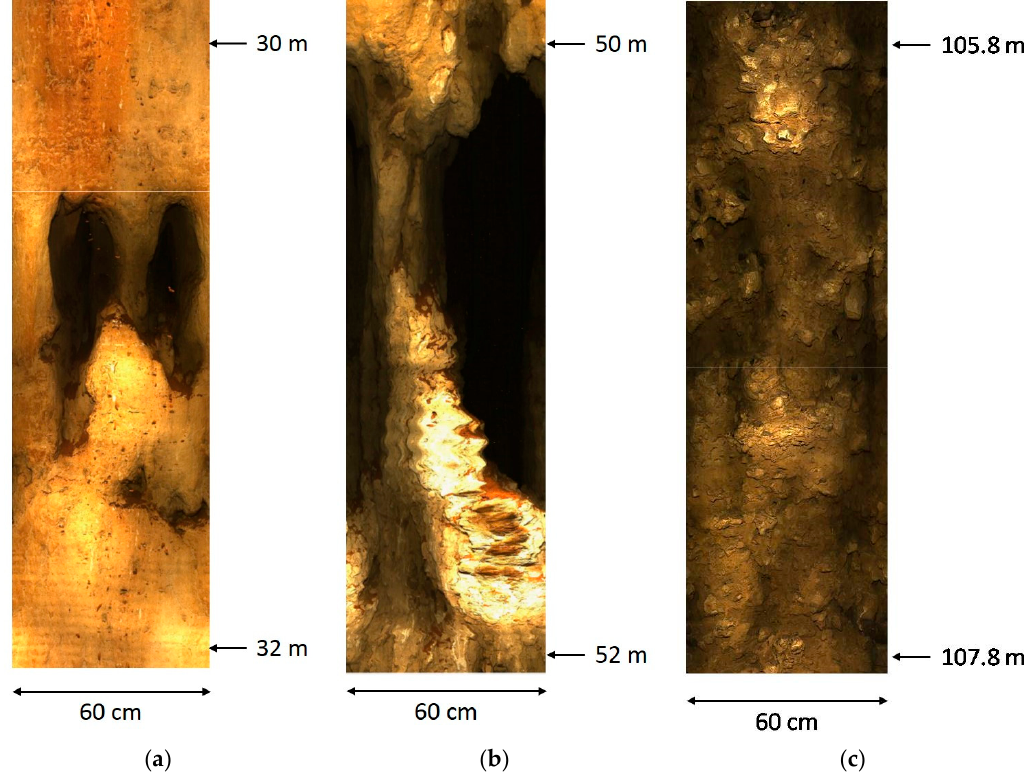
Figure 6. Borehole televiewer (BHTV) optic images at well M04 ( a ) at depth 31 m, ( b ) at depth 51 m, ( c ) at depth 107 m.